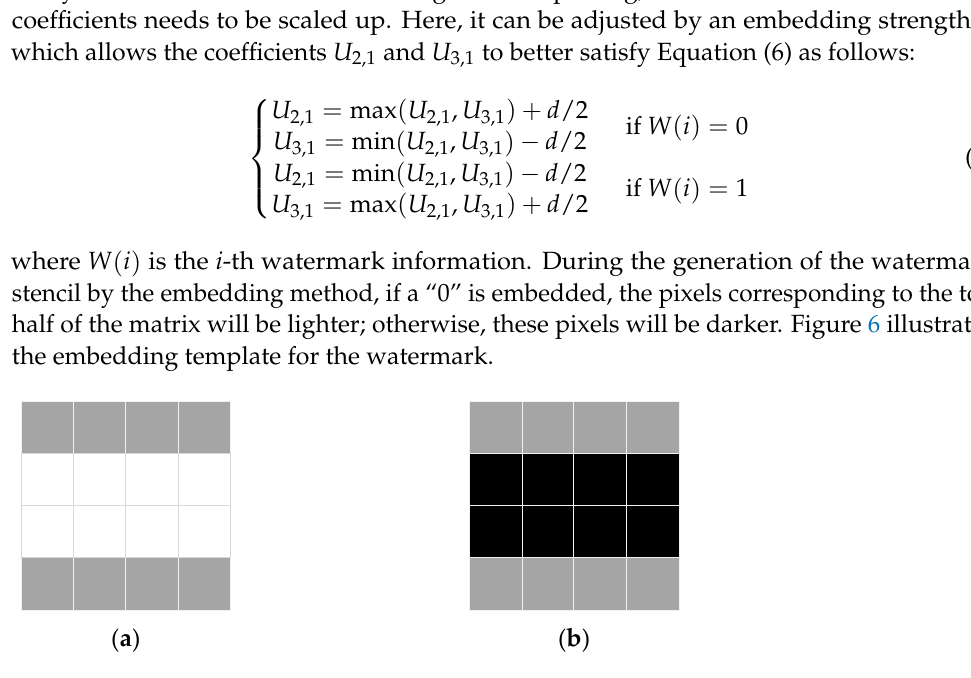
Figure 5. The DWT-SVD embedding watermark process.